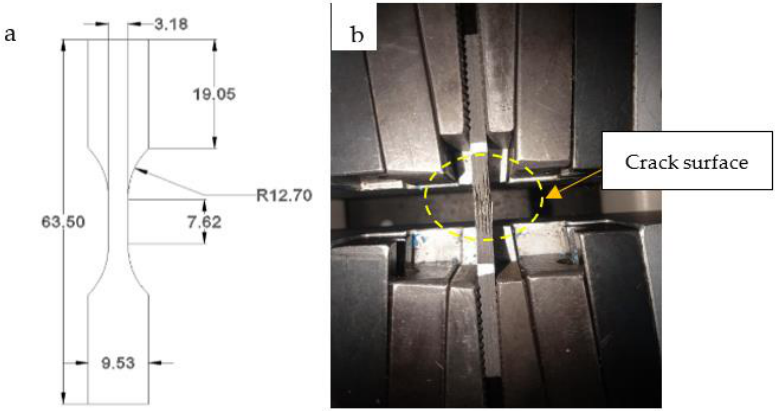
Figure 1. Tensile specimen of composite: ( a ) geometry of tensile specimen; ( b ) tensile failure specimen.